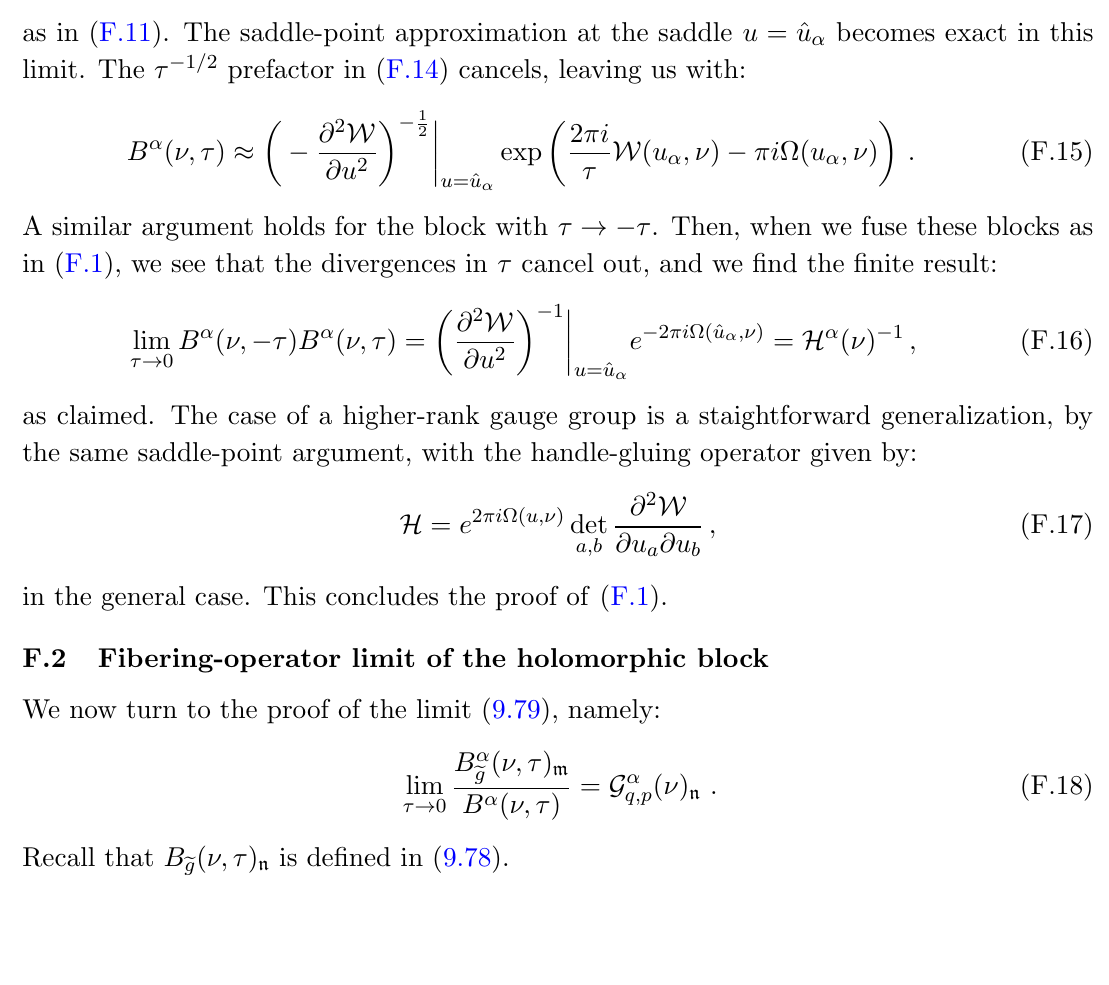
becomes exact in this (cid:11)